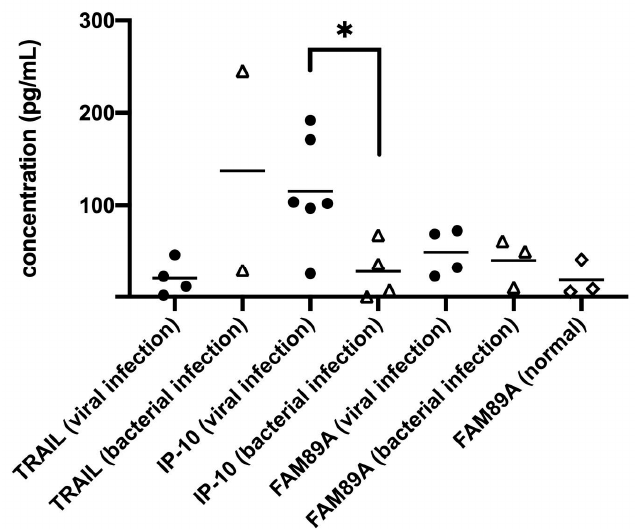
Figure 2. Several biomarkers applied to detect infection modes in children, including TNF (Tumor necrosis factor)-related apoptosis-inducing ligand (TRAIL), interferon γ -induced protein 10 (IP-10) and family with sequence similarity 89 member A (FAM89A). The symbols ( ●△◇ ) in this figure mean different patient samples in different study groups. The IP-10 concentration in urine demonstrated a significant difference between viral and bacterial infections (* p < 0.05).